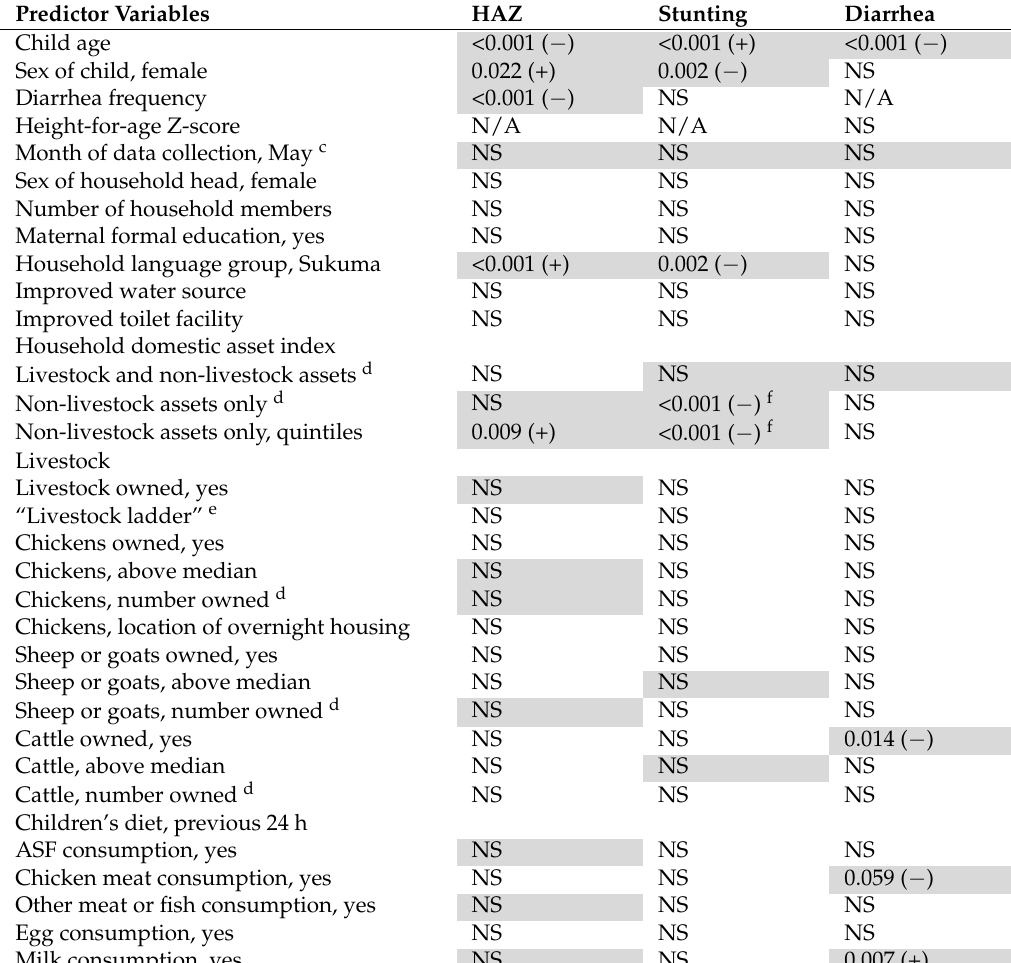
Table 5. Multivariable models for height-for-age Z-scores (HAZ) a , probability of stunting (HAZ < − 2) b and diarrhea frequency b in children, showing p -values and the direction of significant ( p < 0.05) and suggestive (0.05 ≤ p < 0.1) associations. Grey shading indicates significant and suggestive associations in univariable models (Table A3), and “NS” denotes non-significant associations in final multivariable